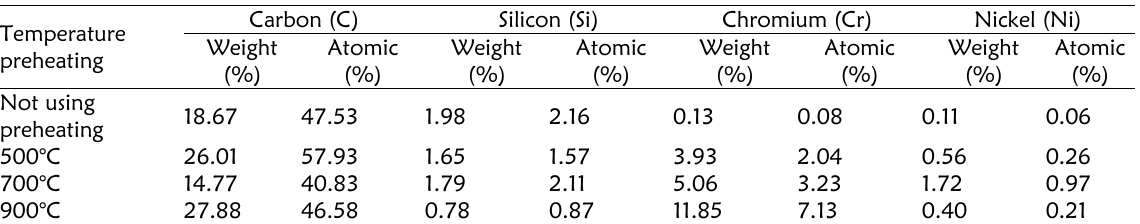
Table 3: EDX weight ratio of elements deposition (CrNi) using three spectrums focused on three distinct areas of surface for all